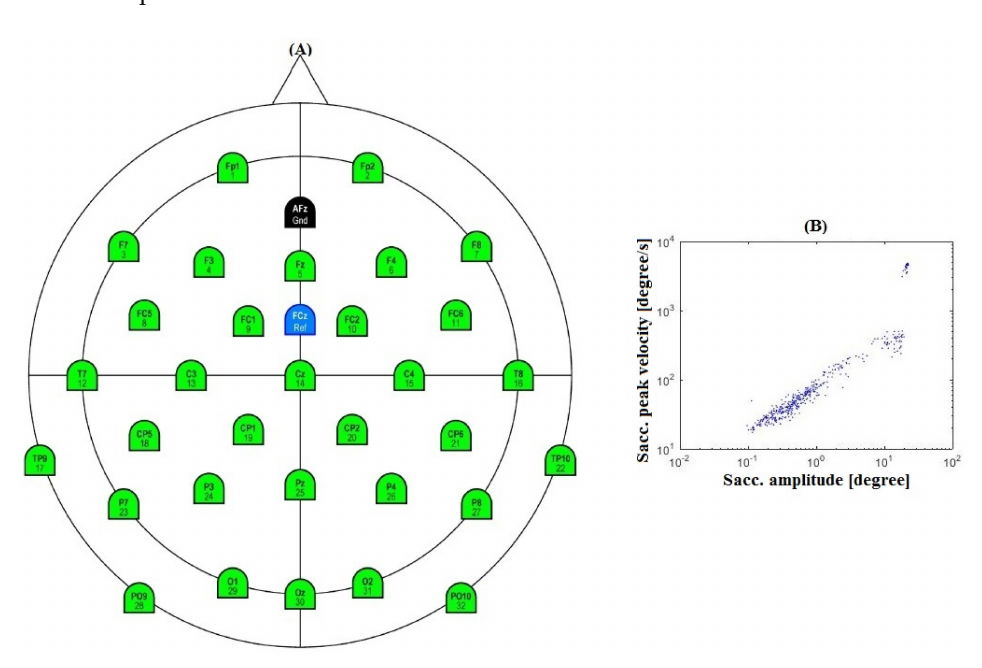
Figure 3. ( A ) Electroencephalogram (EEG) electrode configuration; ( B ) Distribution of saccade